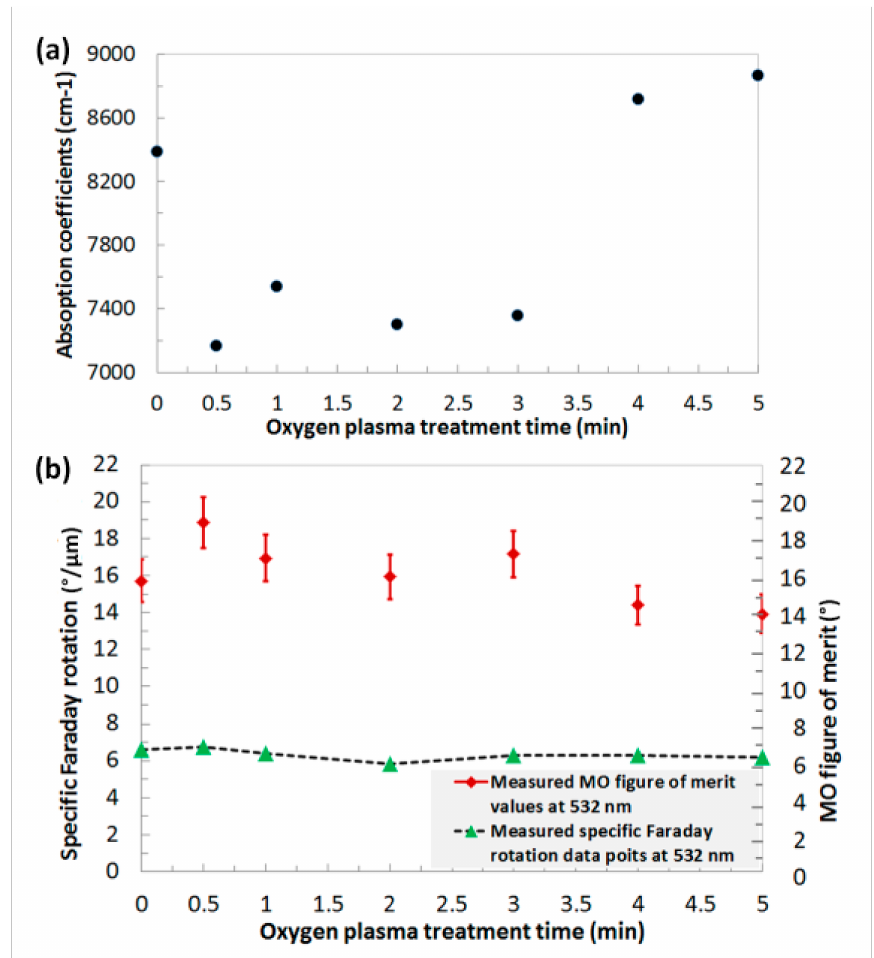
Figure 4. Measured optical absorption coe ffi cients ( a ), specific Faraday rotation and magneto-optic (MO) figure of merit data points ( b ) at 532 nm in optimally annealed O 2 plasma treated and non-treated Bi 2.1 Dy 0.9 Fe 3.9 Ga 1.1 O 12 garnet